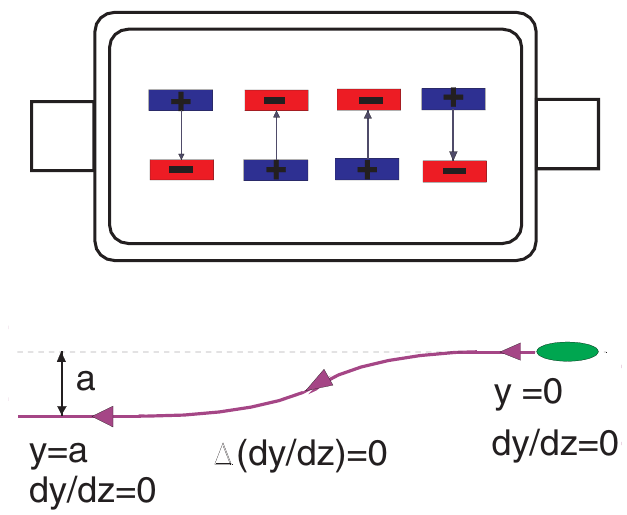
FIG. 11. (Color) The rf deflector with inversion.